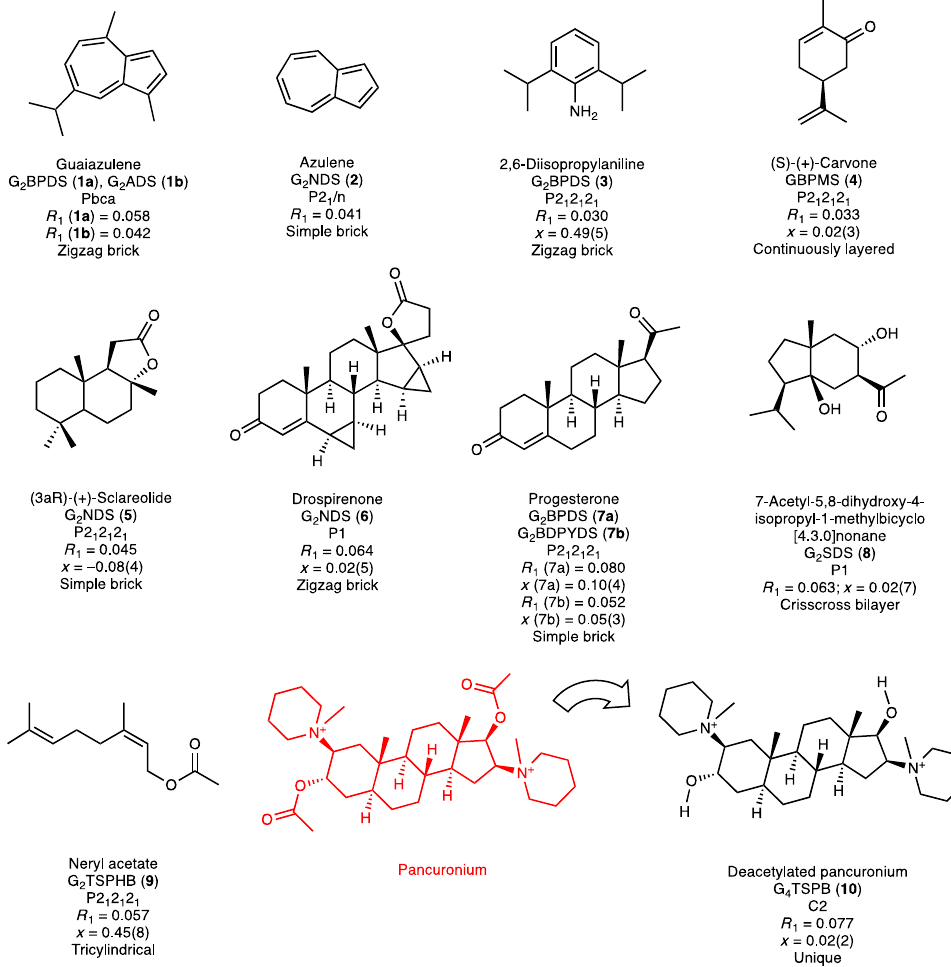
Fig. 3 Target molecules, in GS frameworks, characterized by single crystal X-ray diffraction. The GS framework(s) corresponding to each target molecule and the R 1 values for observable re fl ections are provided. Flack parameters ( x ) are given for compounds that crystallized in chiral space groups. Values of x near 0.5 observed for achiral guests are consistent with twinning. The near-zero value and high precision of the Flack parameters ( x ) for inclusion compounds with chiral guests provides con fi dence in the assignment of absolute con fi guration 44 . The deacetylated pancuronium was trapped as a hydrolysis product of pancuronium during crystallization, but without a conventional GS